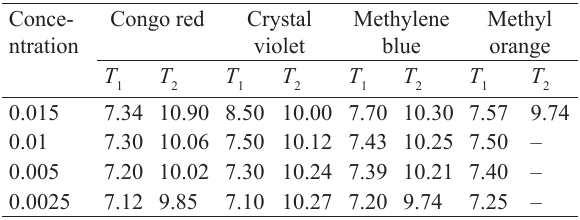
Table 1 Adsorption coefficient of dyes at contact time of 30